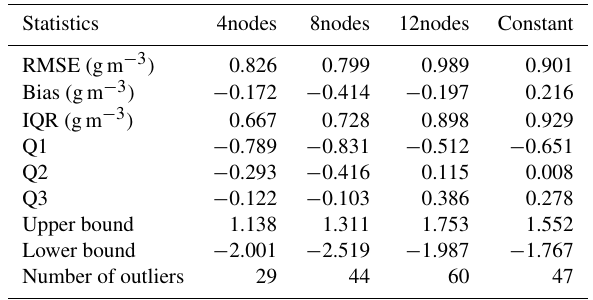
Table 4. Statistics and characteristic values of box plots showing the differences between the four schemes and water vapor measure- ments constructed by HKKP’s radiosonde data for 7 days (DOY 214–220) in